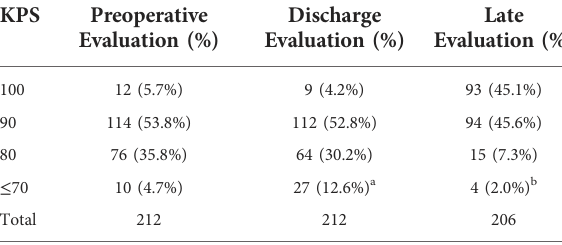
TABLE 5 The KPS evaluation at the preoperation, discharge and late time